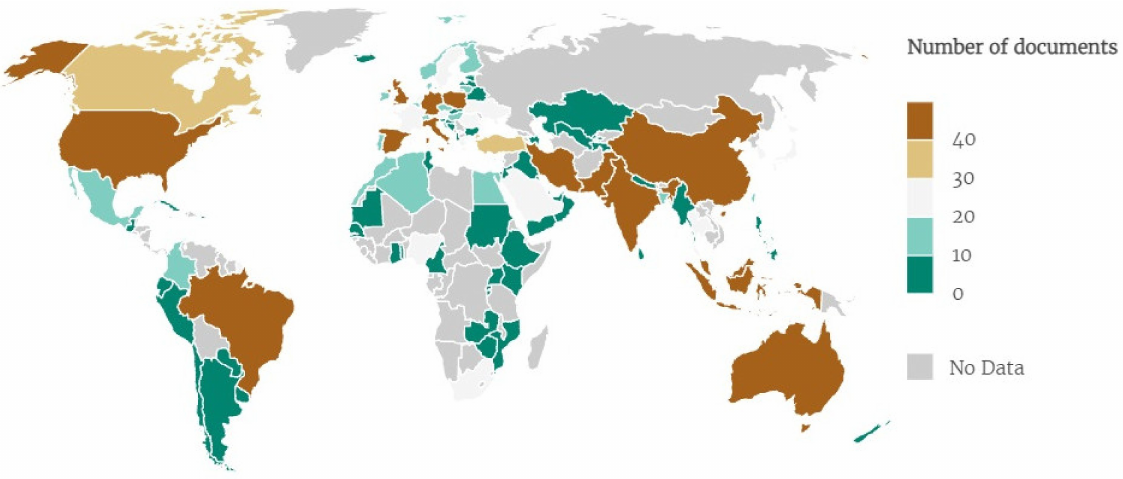
Figure 4. Worldwide scientific production related to renewable energy and agriculture (2019–2021).